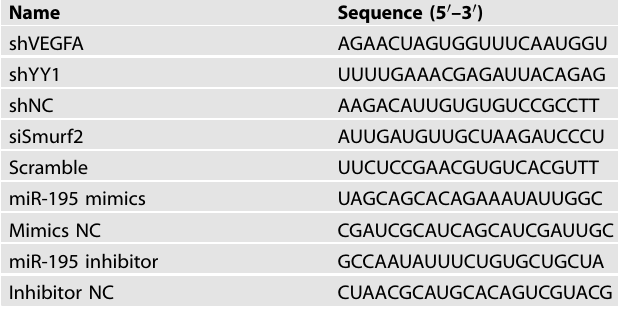
Table 1. The sequences for oligos in this study.